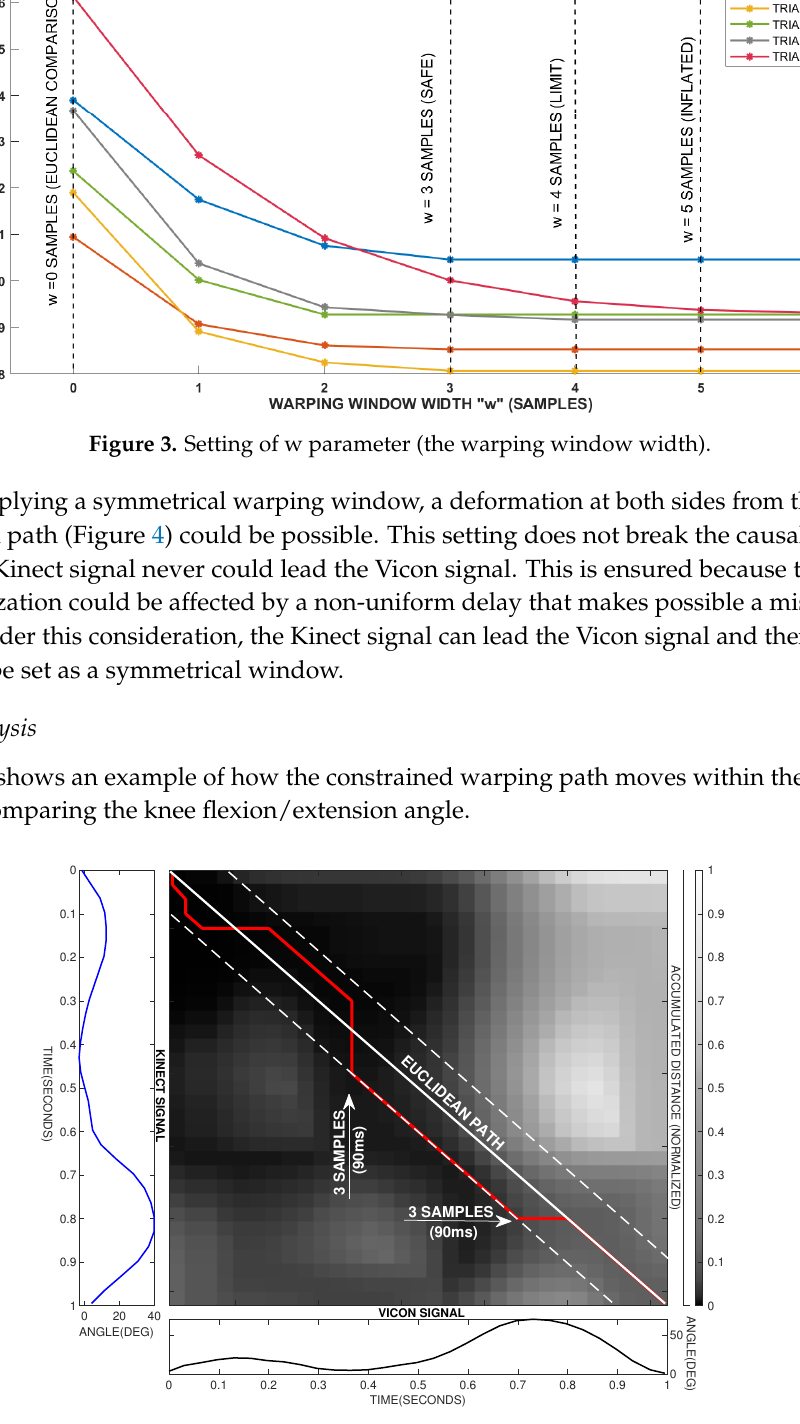
Figure 4. An example of how the DTW algorithm operates to find similarities between both signals. The movement belongs to the knee flexion/extension. The accumulated distance matrix obtained is shown in gray scale. The Vicon signal is shown as a black line and the Kinect signal as a blue line. The dotted white lines represent the limits of the Sakoe–Chiba band for a warping constraint w = 3 samples . The continuous white line represents the Euclidean path. The red line represents the warping